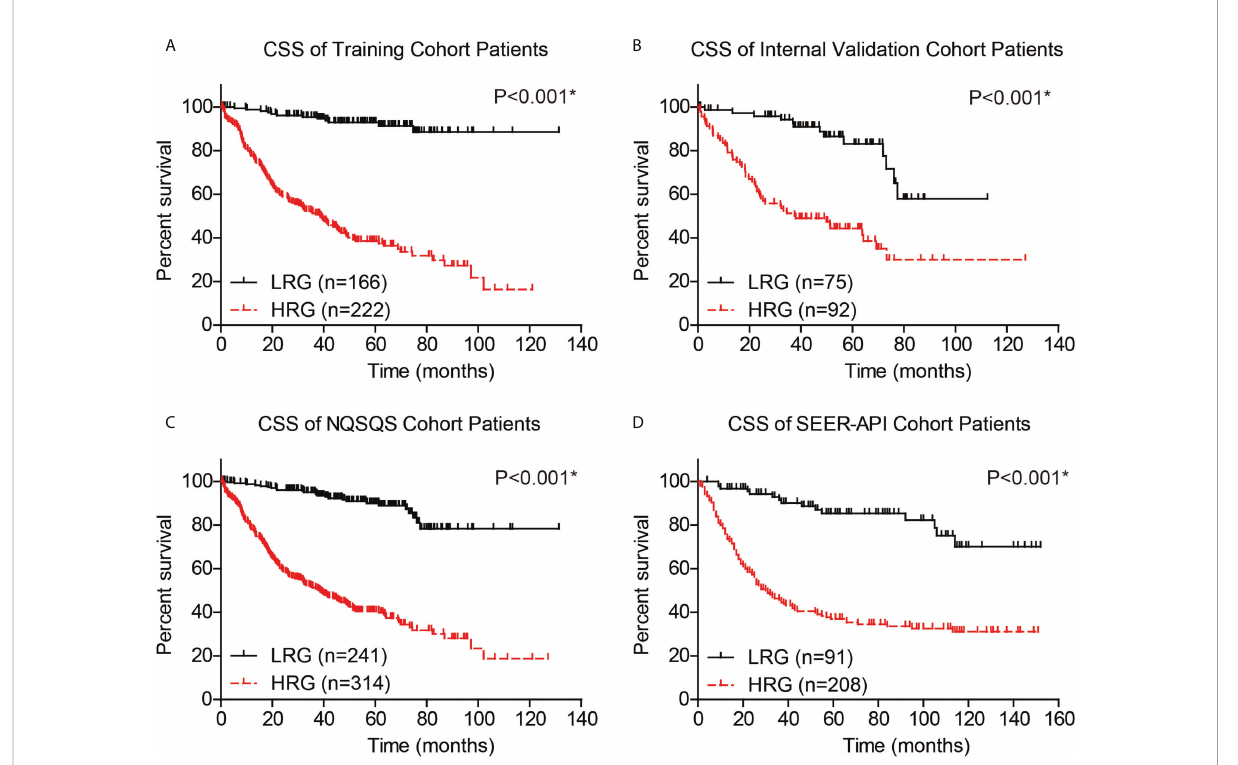
FIGURE 6 Cancer-speci fi c survival (CSS) analyses of EOGC patients based on the risk model. Based on the risk model, EOGC patients were divided into high-risk group (HRG) and low-risk group (LRG), then the CSS curves were plotted in the training set (A) , internal validation set (B) , combined NQSQS cohort (C) , and SEER-API external validation set (D) , respectively. *indicates P<0.05 by log-rank